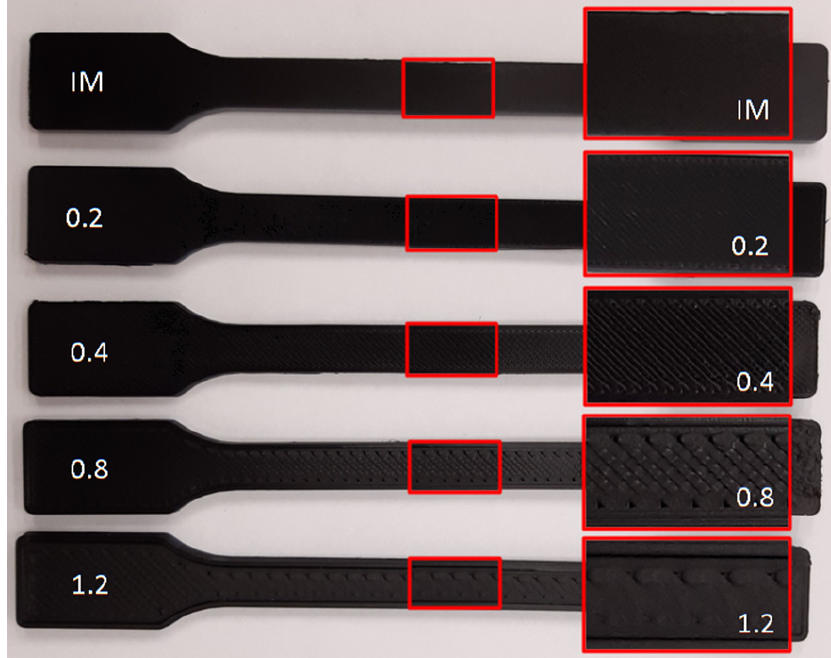
Figure 5. Filling structure of injection molding and 3D-printed samples.